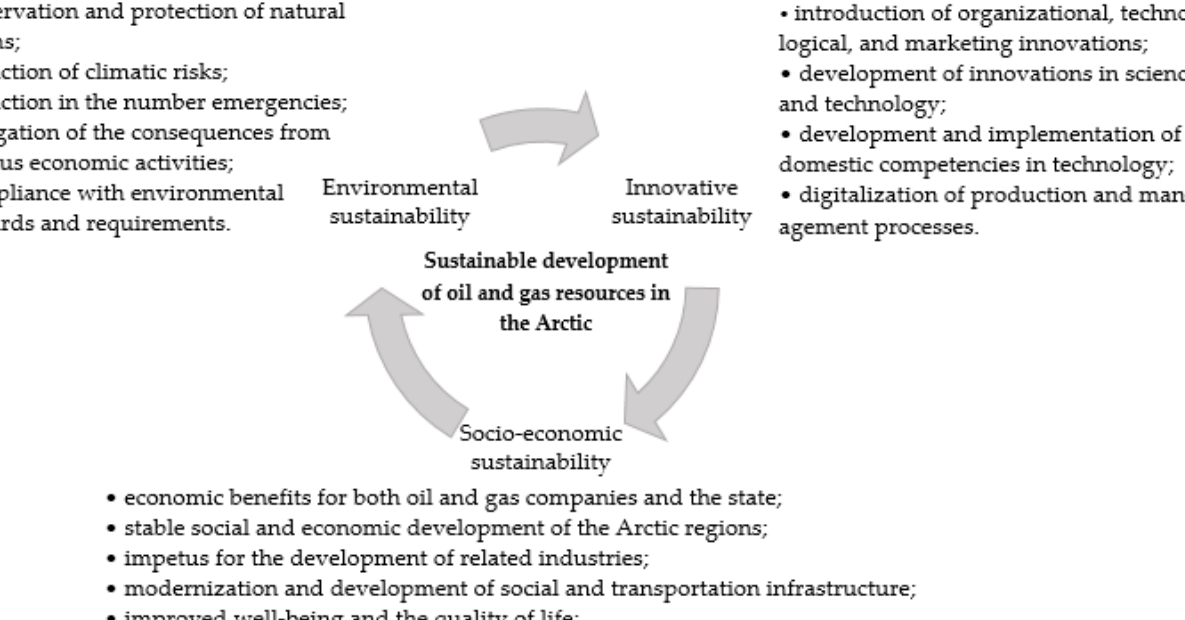
Figure 3. Environmental, socio-economic, and innovative sustainability of the development of oil and gas resources in the Arctic. Source: created by the authors.